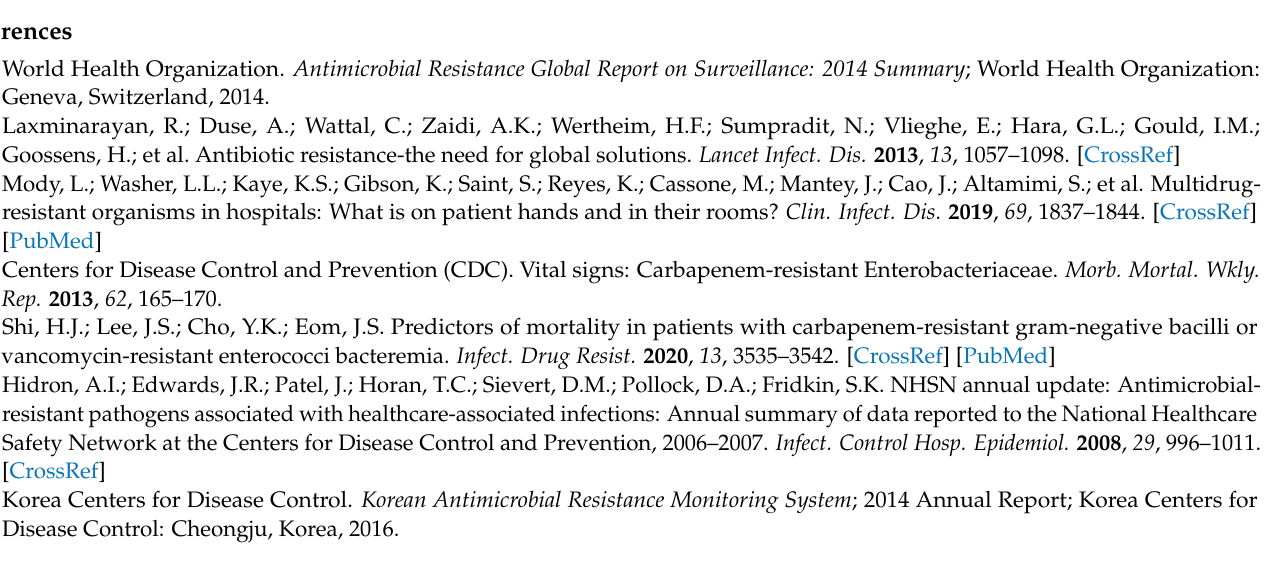
Figure S3: Taxonomic linear discriminant analysis effect size (LEfSe) analysis of the 16S sequences with the greatest differences in abundance between the 1-month negative-conversion and 1-month non-negative-conversion groups; Table S1: Comparison of antibiotic use between the fecal microbiota transplantation and control groups; Table S2: Analysis of age and antibiotic use among study participants associated with 1-month negative conversion and 3-month negative conversion; Table S3: Analysis of age and fecal microbiota transplantation method for enrolled patients associated with 1-month negative conversion and 3-month negative